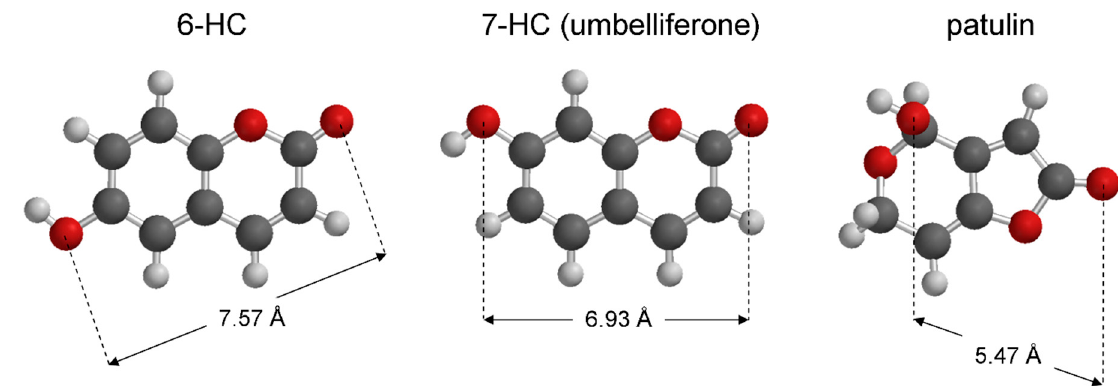
Figure 6. Structures of 6-hydroxycoumarin (6-HC), umbelliferone (7-hydroxycoumarin, 7-HC), and patulin represented as the corresponding most stable conformers (DFT B3LYP/6-31G*//DFT B3LYP/6-31G*); the distances between the OH and the C=O groups of each compound are highlighted.